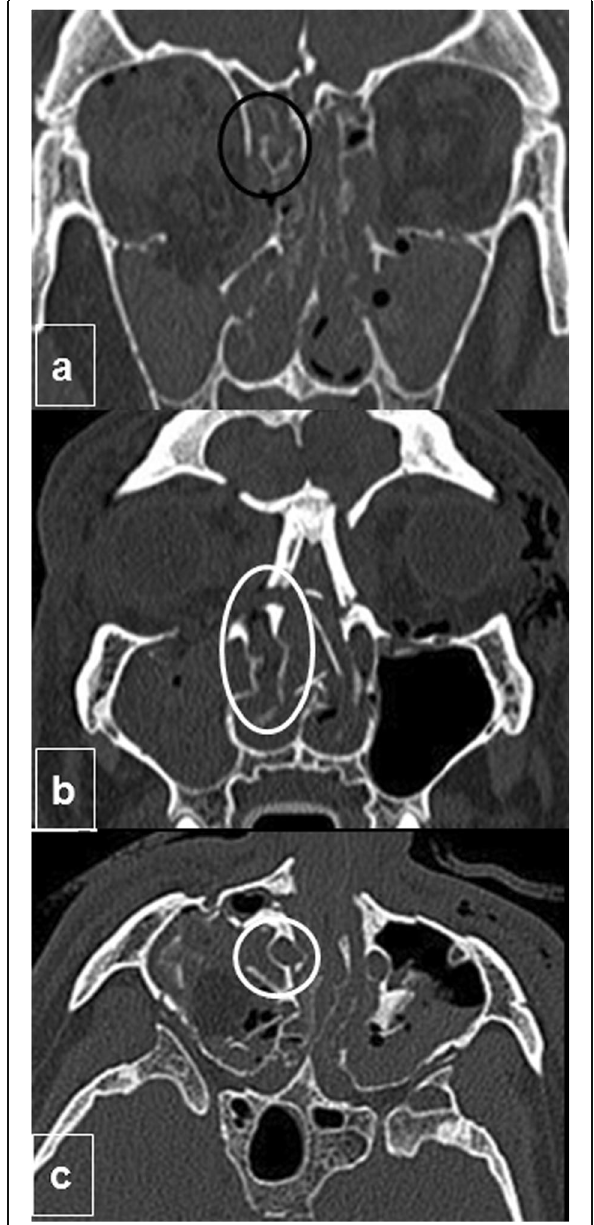
Fig. 5 Complications involving drainage canals. a Coronal CT image shows frontal recess involvement by fracture (black circle). b Coronal and ( c ) axial CT images at the level of the maxillary sinus showing extension of naso-orbito-ethmoidal complex fractures through both nasolacrimal ducts on the right side (circled in